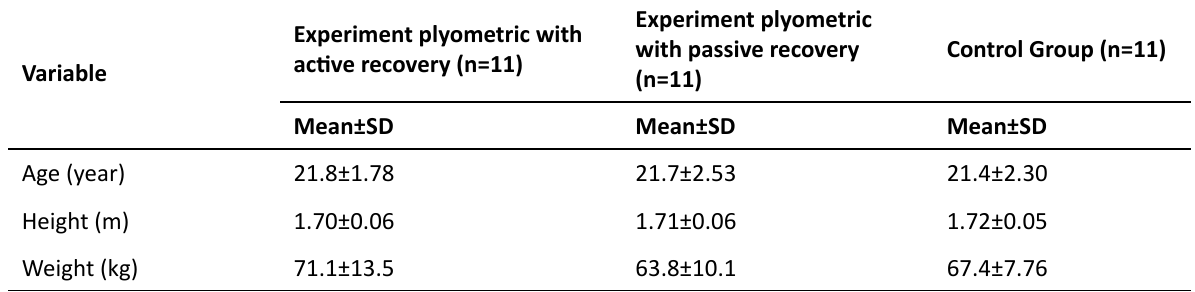
Table 1 . Information on The Characteristics of Participants in Each Group (Mean±SD)